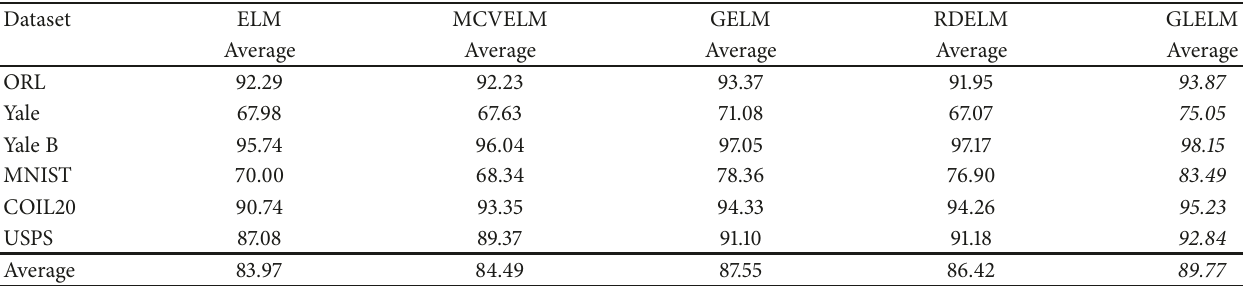
Table 2: Average (sum average recognition rate of different training samples per subject) recognition rate of different ELM algorithms on image datasets (%).